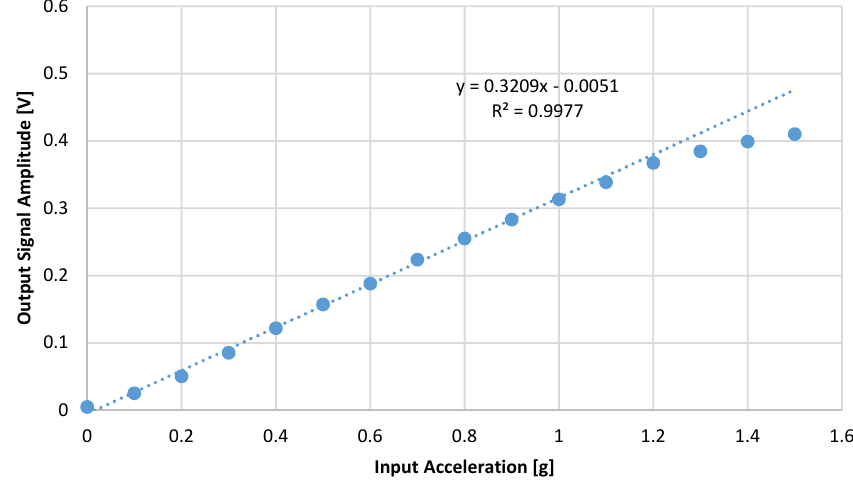
Figure 15. The output signal amplitude versus acceleration.